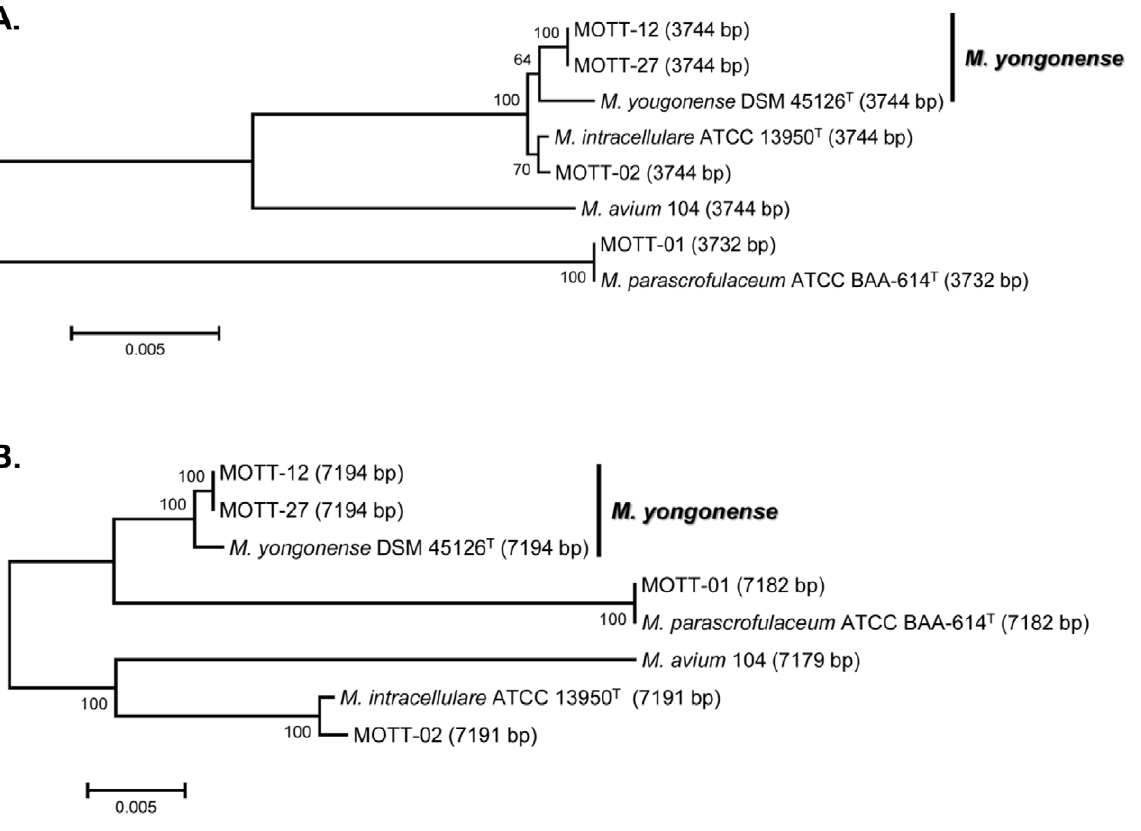
Figure 2. Phylogenetic relationships based on concatenated sequences of ( A ) the five MLSA genes ( 16S rRNA, hsp65 , dnaJ , recA and sodA ) ( 3732 or 3744 bp ) and ( B ) with the addition of the full rpoB sequence to the concatenated sequences of the five MLSA genes ( 7182–7194 bp ) ( B ) . These trees were constructed using the neighbor-joining method. The bootstrap values were calculated from 1,000 replications; bootstrap values of , 50% are not